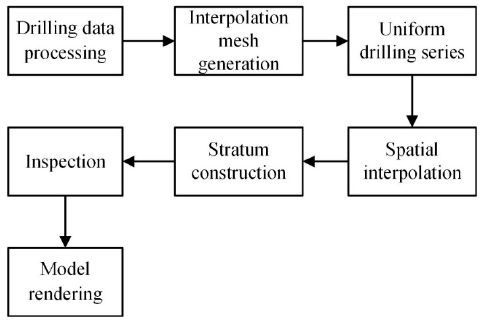
Figure 36. Schematic diagram of stratum construction.